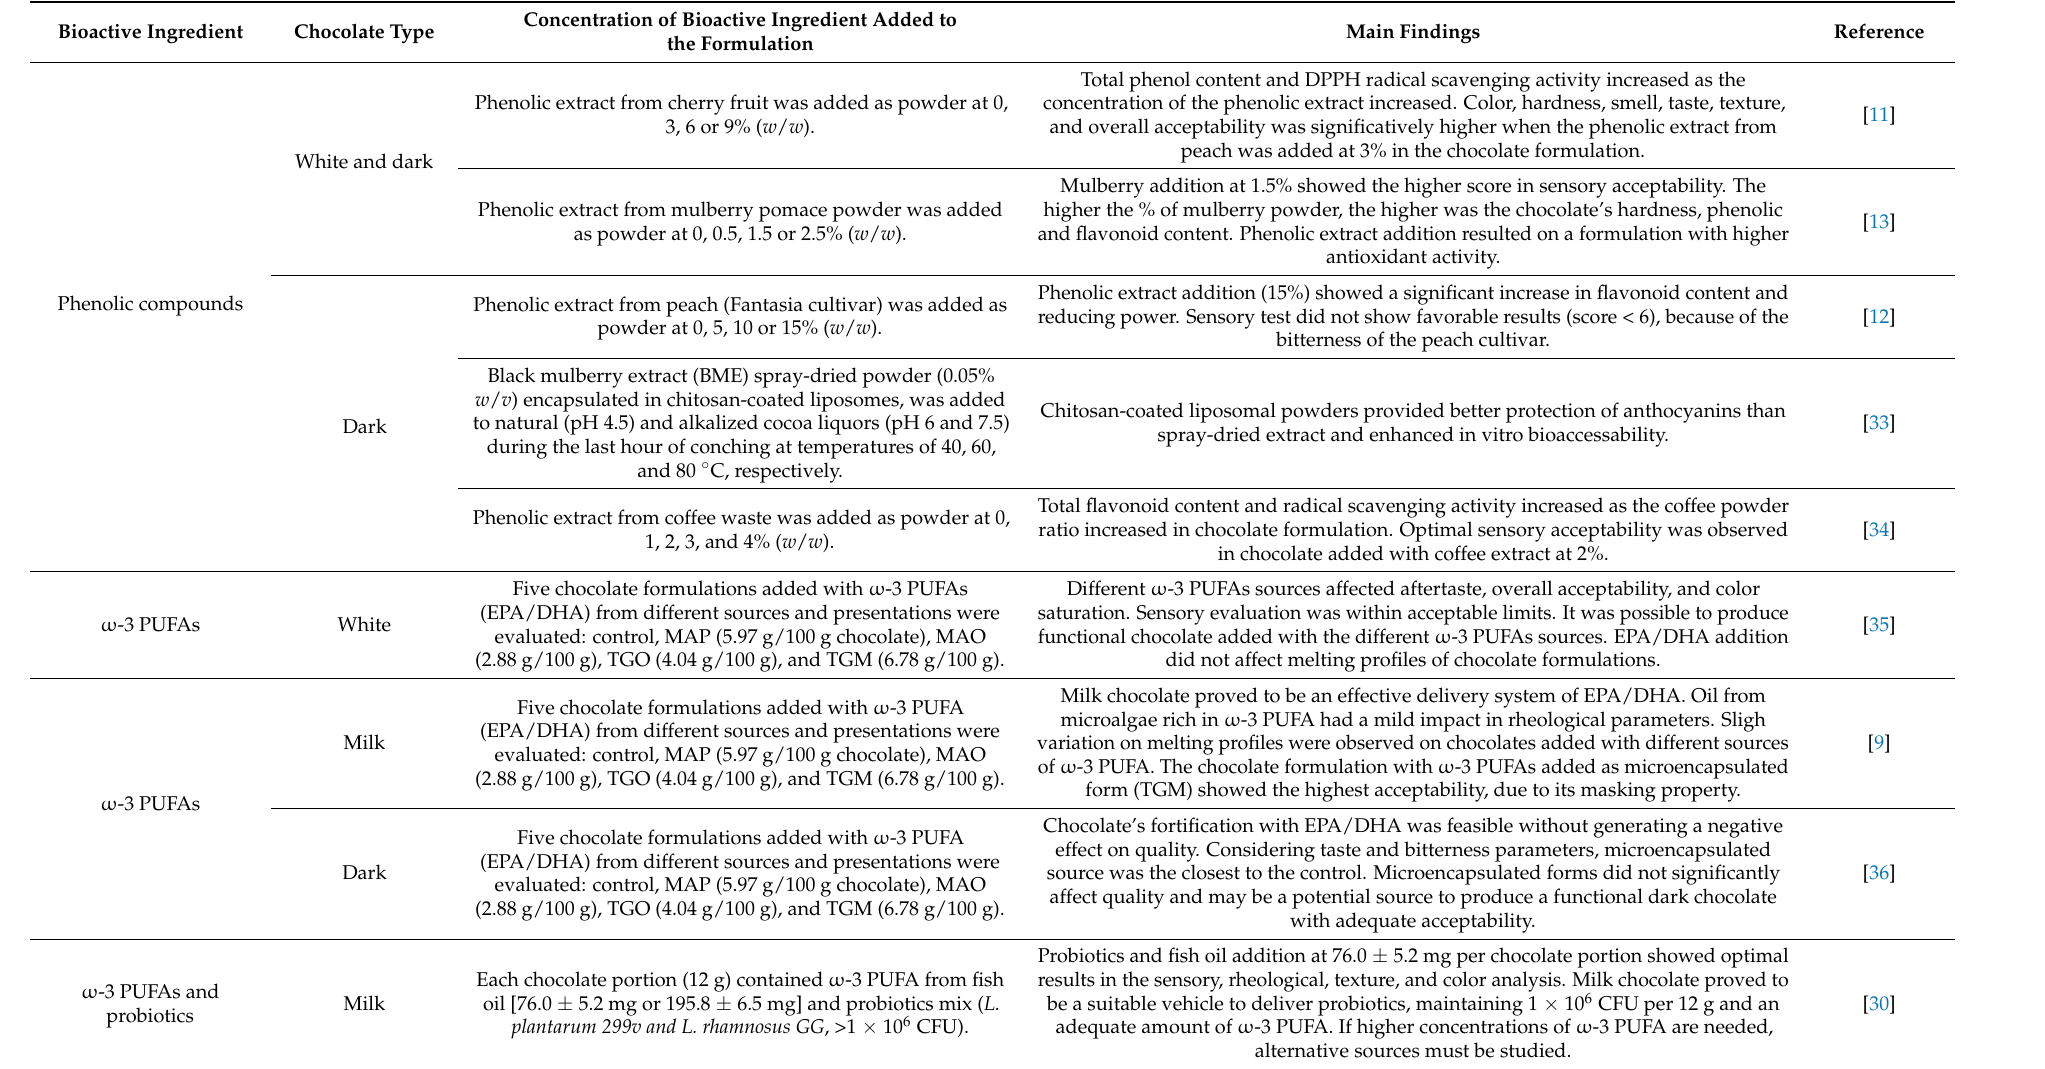
Table 1. Effect of bioactive ingredients addition on the physicochemical and sensory properties of chocolate